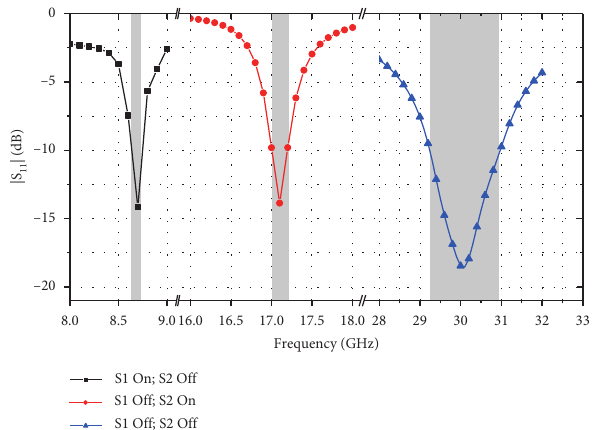
Figure 11: Simulation results of the reflection coefficient of FRAA.